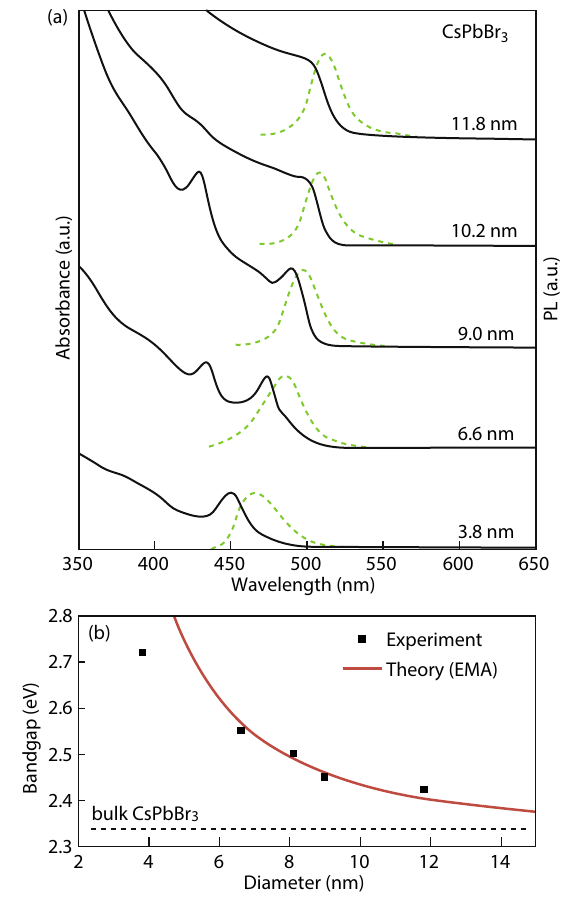
Fig. 11 a Quantum size effects in the absorption and emission spectra of 5–12-nm CsPbBr 3 NCs. b Experimental versus theoreti- cal (effective mass approximation) size dependence of the band gap energy. Reprinted with permission from Ref. [28]. Copyright Ameri- can Chemical